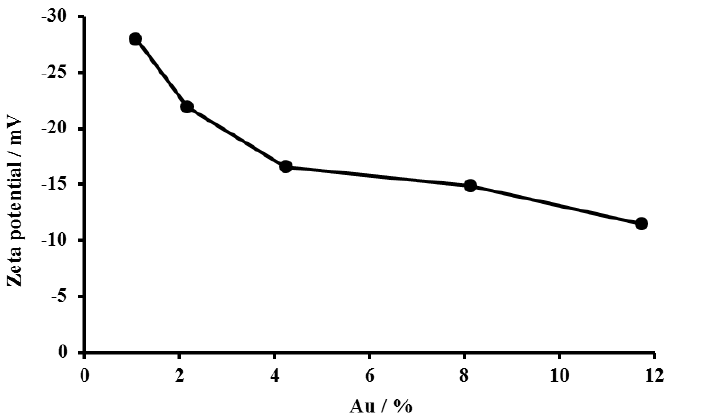
Figure 4. Zeta potential of the prepared core − shell Au@TiO 2 material with varying Au content (1.09, 2.17, 4.24, 8.14 and 11.74%).